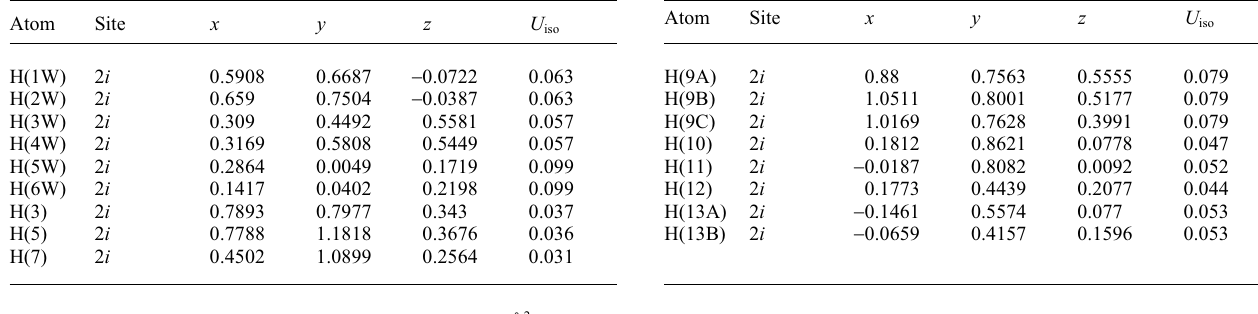
Table 3. Atomic coordinates and displacement parameters (in Å 2 ) .